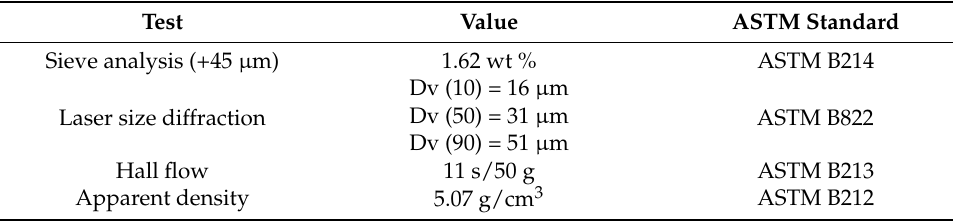
Table 2. Characterization of the Cu powder used in this study.